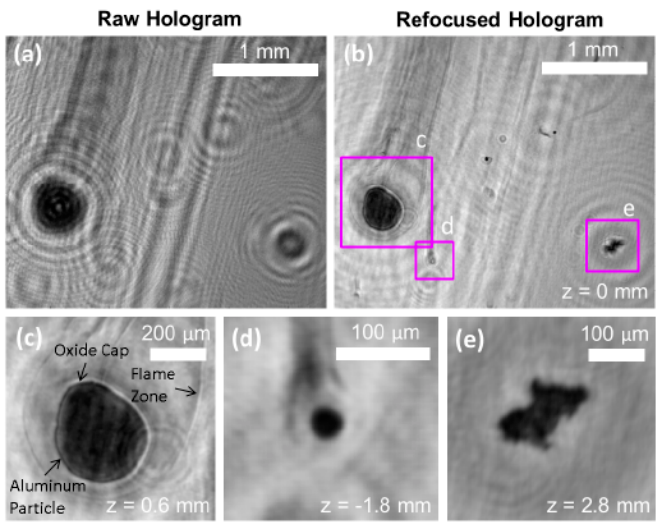
Figure 37. Stick’s burning surface. Reprinted with permission from Ref. [49] (2017).